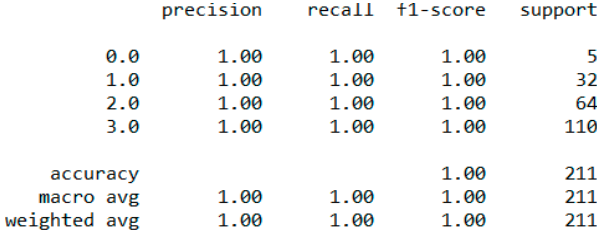
Figure 8. Performance metric of “Decision Tree” classification with 5-fold cross validation.